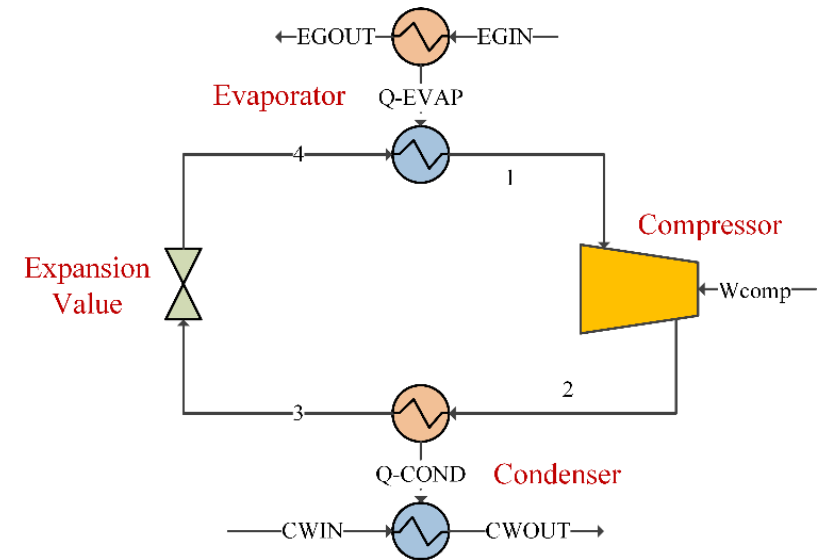
Figure 3. Schematic diagram of the vapor compression refrigeration cycle.